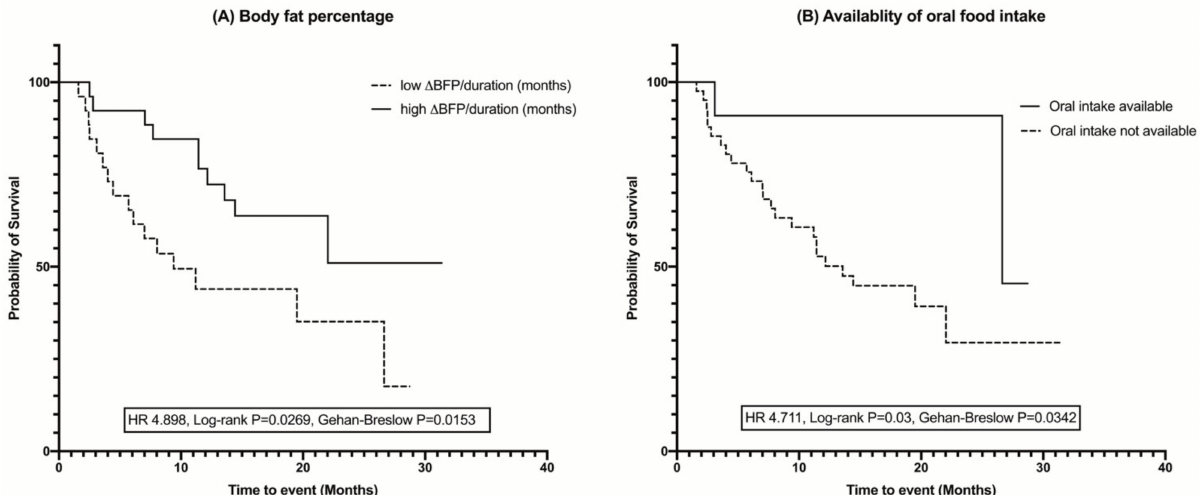
Figure 3. Kaplan–Meier curves and log-rank test for survival analysis showing the difference in the duration of survival in ALS patients: ( A ) Body fat percentage, ( B ) Availability of oral intake. Groups were divided based on the median values for body fat percentage. The higher body fat percentage and availability of the oral food intake increased the survival duration in ALS patients. ∆ —interval change (follow-up – baseline values); BFP—body fat